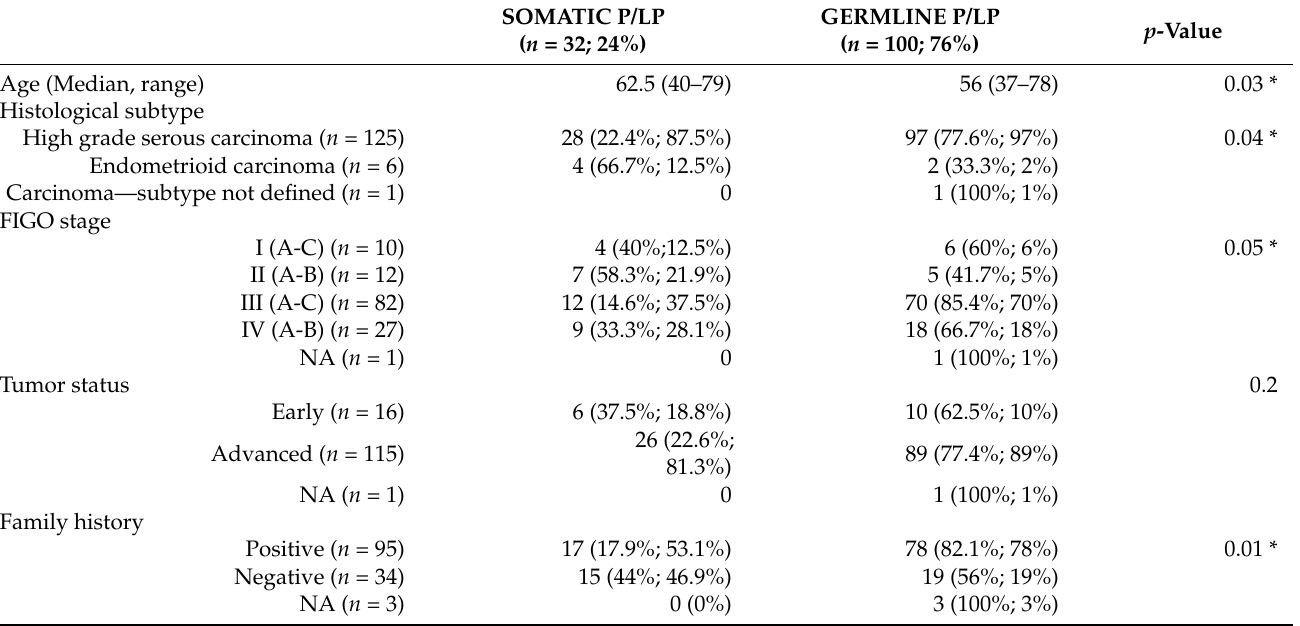
Table 5. Somatic and germline BRCA pathogenic/likely pathogenic variants. Distribution of clinico- pathological features according to the somatic or germline nature of the P/LP alterations. Number of cases (percentage row; percentage column). P/LP: pathogenic/likely pathogenic variants; NA: Not Availabletest; P/LP: pathogenic/likely pathogenic variants; VUS: Variants of Unknown clinical Significance; WT: Wild